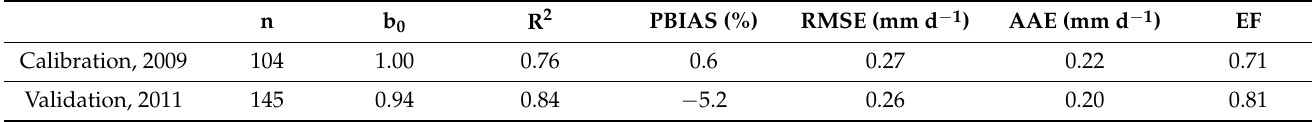
Figure 2. Actual crop transpiration dynamics measured with sap flow (T SF field ) and simulated with SIMDualKc after model calibration (T c act ) for ( a ) 2009 and ( b ) 2011. Table 4. Goodness-of-fit indicators relative to the comparison between simulated transpiration (T c act ) and the corresponding values obtained from sap-flow measurements (T SF field